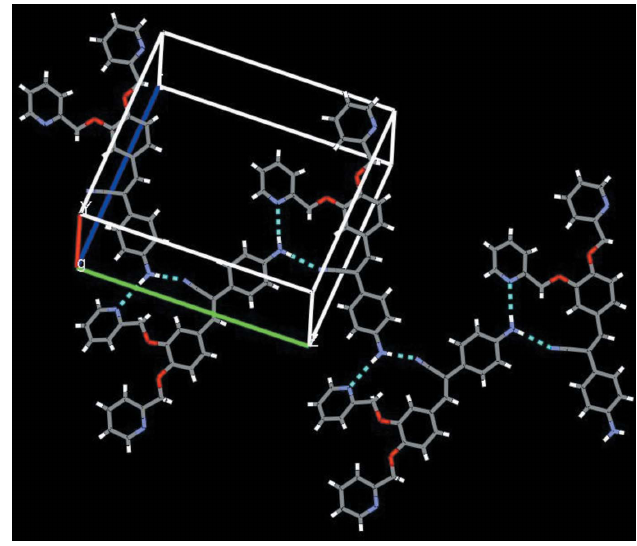
Figure 2 Hydrogen bonds in the crystal packing of the title compound. N—H (cid:2)(cid:2)(cid:2) N hydrogen bonds are drawn with dashed